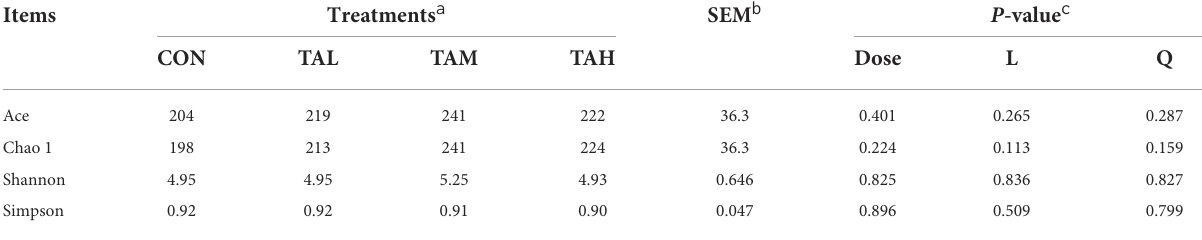
TABLE 6 Effects of tannic acid at different doses on Alpha diversity indices of the bacterial community in the rumen fluid of black goats.